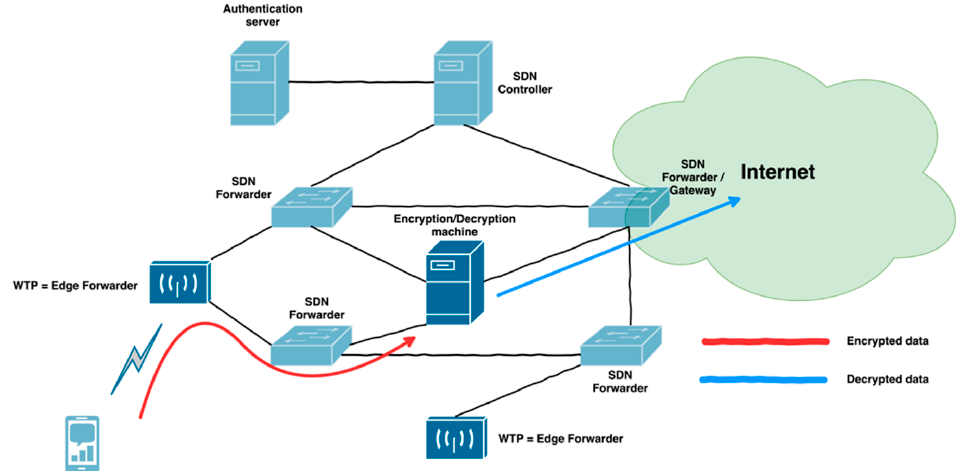
Figure 4. Data flow to the Distribution System.